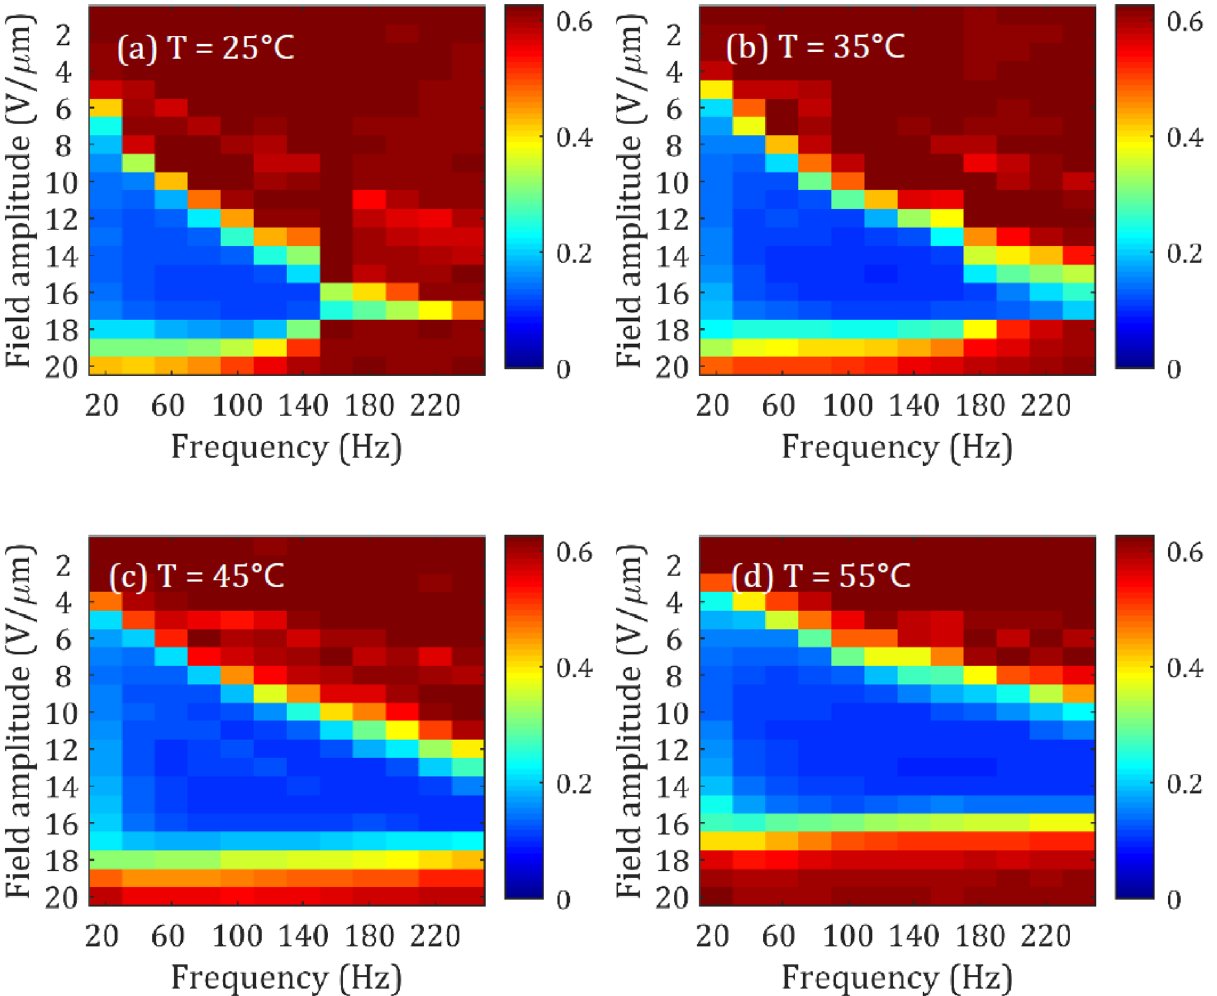
Figure 6. Speckle contrast maps measured for the chiral nematic LC device (E7 + 5.1 wt% BDH1281, pitch 273 nm) for four different operating temperatures. The cells tested were nominally 20 µm-thick and the cell temperature throughout measurements was ( a ) T = 25 °C, ( b ) T = 35 °C, ( c ) T = 45 °C, ( d ) T = 55